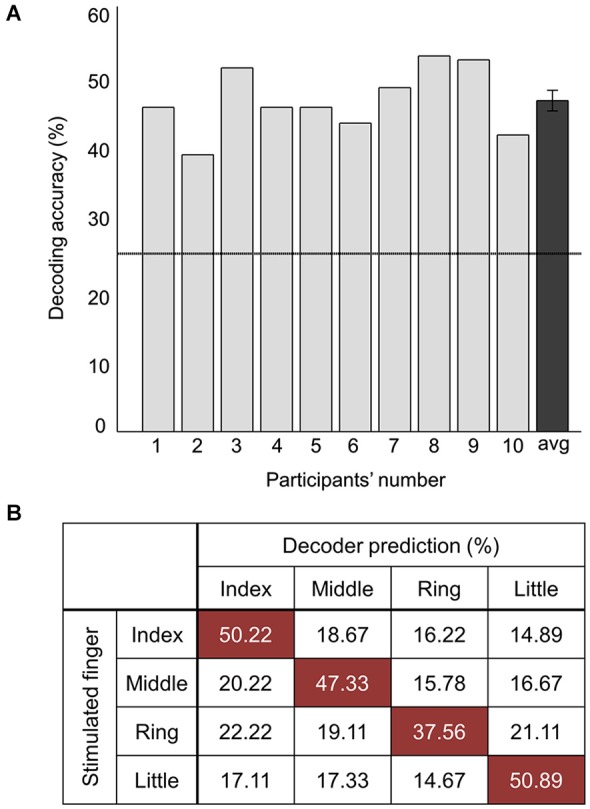
Decoding performance combining all the voxels of significant clusters. (A) Average decoding accuracies of ten participants from searchlight MVPA. The rightmost value indicates the average accuracy across all the participants. Error bars indicate standard errors and a chance level is marked by the dashed line (25%). (B) Confusion matrix for the stimulated finger decoding analysis. The rows of the matrix indicate the locations of vibrotactile stimulus provided to the participants (i.e., true label) and the columns of the matrix indicate the predictions by the decoder (i.e., predicted label). Each cell shows the percentage of correct prediction.